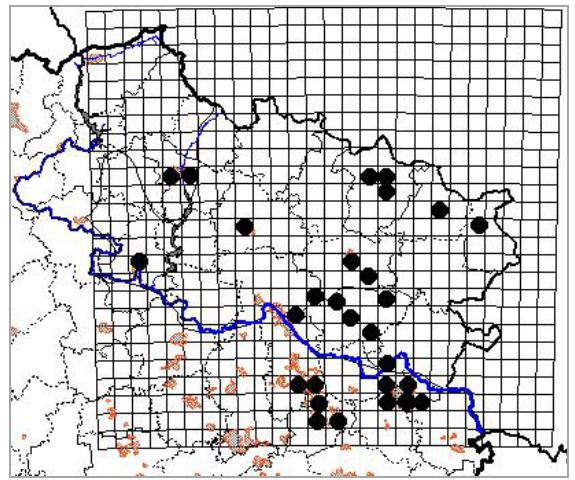
Fig. 25. The map of the distribution of Setaria glauca L. in the Starobilsk grass-meadow steppe